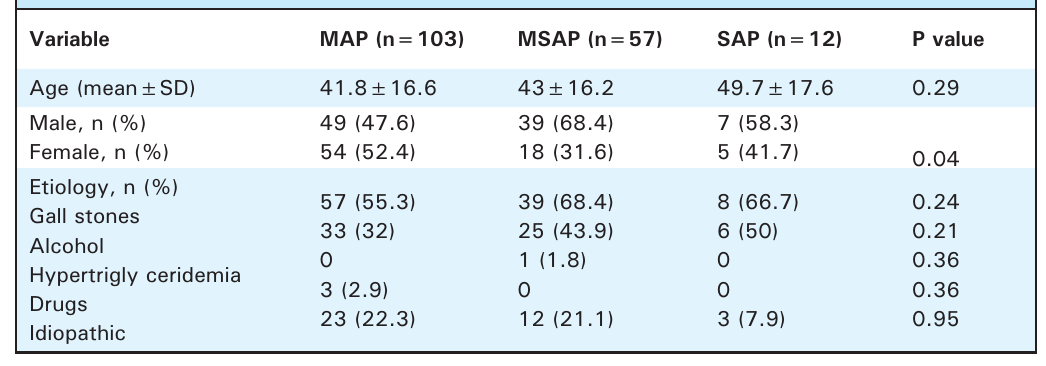
Table 4. Comparison of demographics and etiology between three